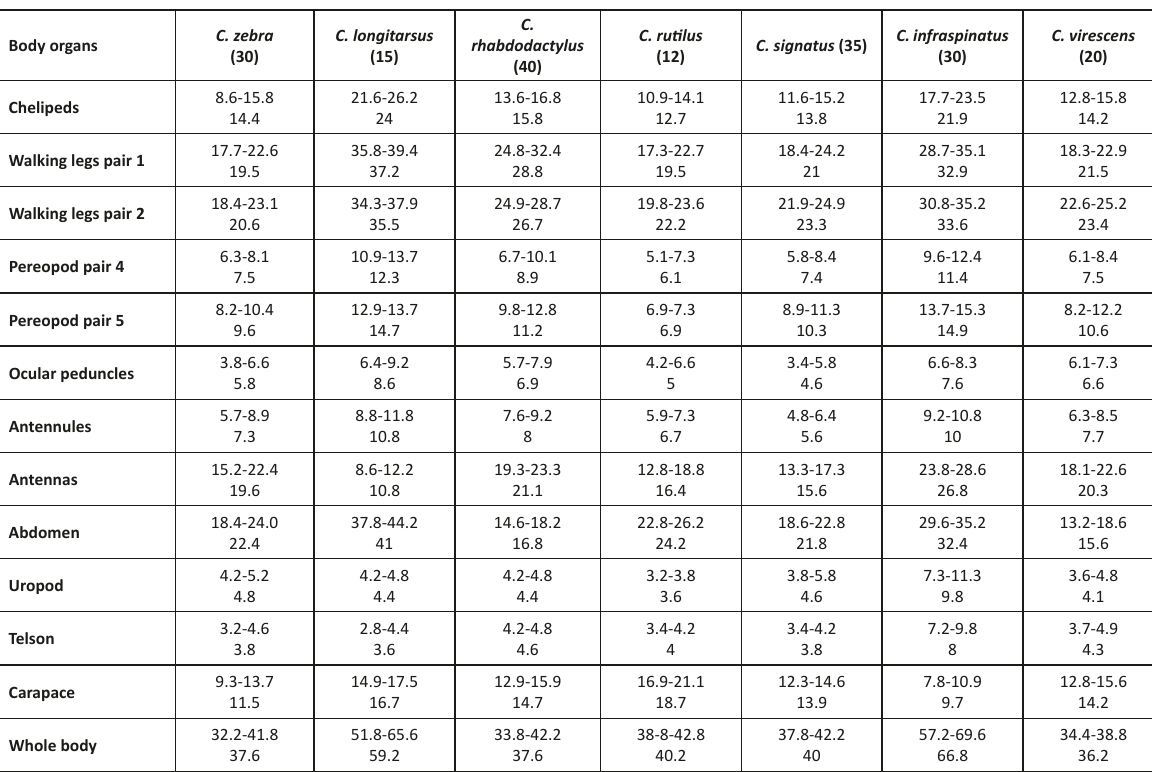
Table 1. Average measurement of different body parts of the hermit crab species reported in this study. Data expressed are minimum-maximum range and average values of all the specimen of each species (the number of specimens is shown in brackets). Body